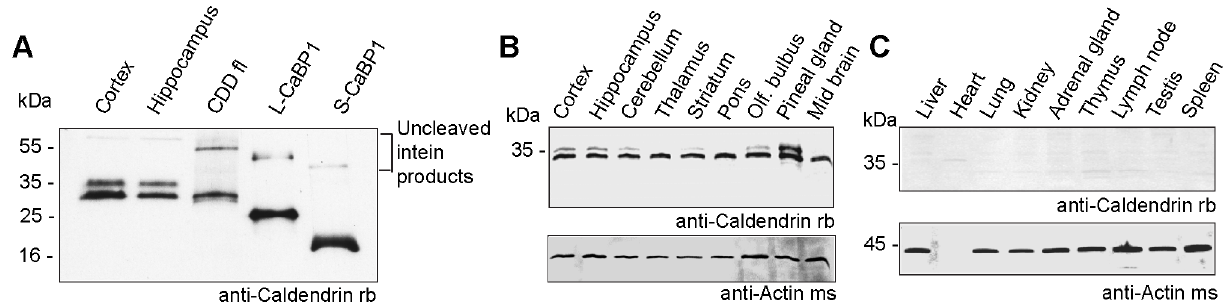
Figure 1. Expression anaylsis of Caldendrin, L- and S-CaBP1. (A) Immunoblot analysis reveals that bacterially expressed untagged Caldendrin migrates at 33 kDa like the smaller Caldendrin isoform in cortex and hippocampus of rat brain. Bacterially produced myristoylated L- and S-CaBP1 migrate at 25 kDa and 18 kDa respectively. Immunoreactivity is detected by anti-Caldendrin/CaBP1 rabbit antibody, directed against the common C- terminus of all three isoforms. 20 m g of brain samples are compared to < 10 ng of purified proteins. The western blot shows Caldendin expression in different regions of rat brain (B) and in different rat organs (C). Caldendrin is detected by anti-Caldendrin/CaBP1 rabbit antibody (rb). Equal loading in all lanes was ensured by measuring the total protein concentraion (20 m g/lane) and verified with an anti-actin mouse antibody (ms). Note that consistant with previous reports the actin band is amost absent in heart tissue due to differnential expression of this marker.